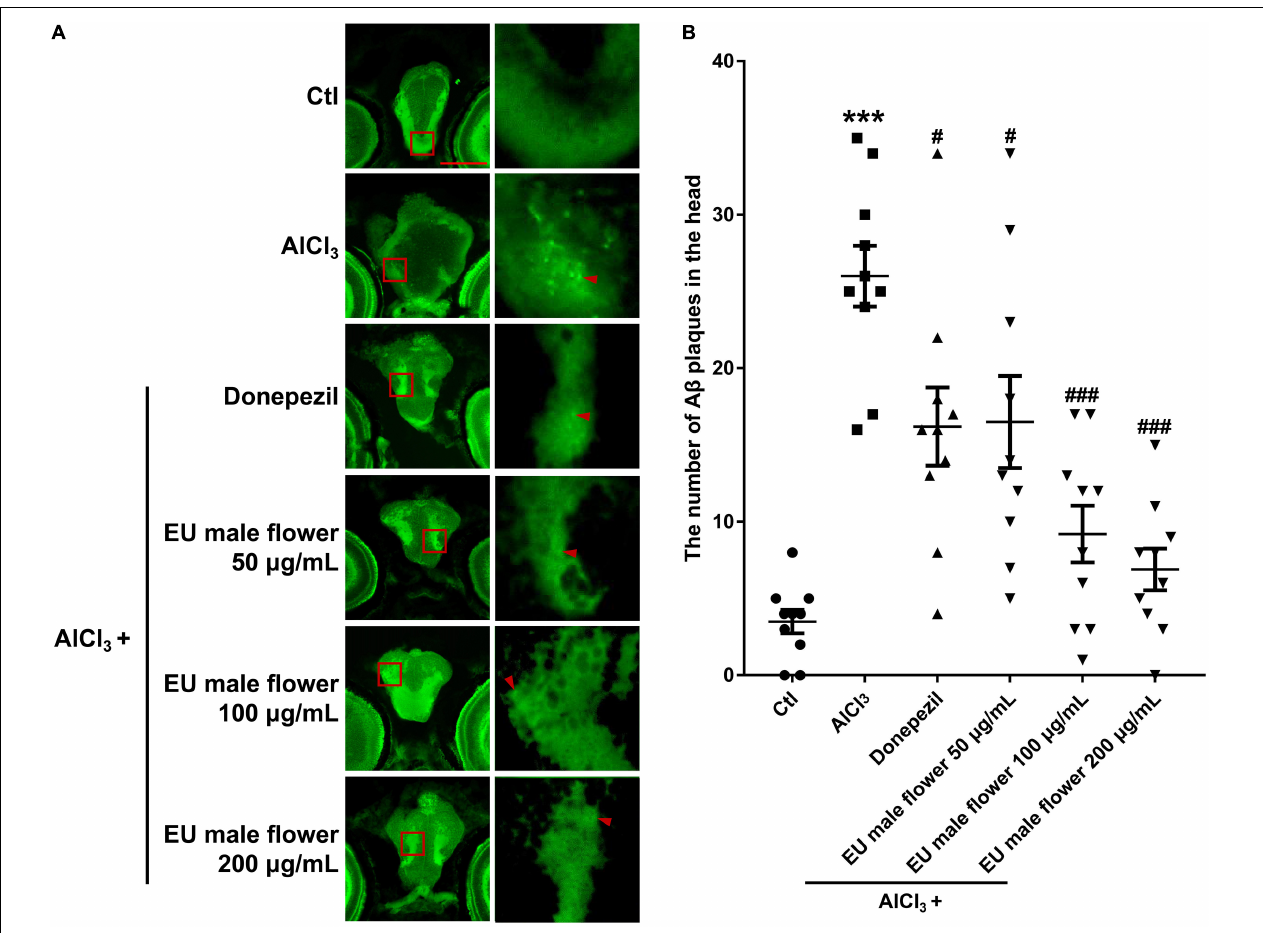
FIGURE 3 | Inhibition of EUMF on A β aggregation in zebrafish. (A) The A β plaques in the brain region were stained using thioflavin S in the Ctl, AlCl 3 , and AlCl 3 + EUMF groups (A β is demarcated by arrows; scale bar = 100 µ m). (B) Statistical analysis of the A β plaque count in each group (*** P < 0.001 vs. Ctl; # P < 0.05; ### P < 0.001 vs. AlCl 3 ; n =